Question: Write a caption explaining this figure to a reader.
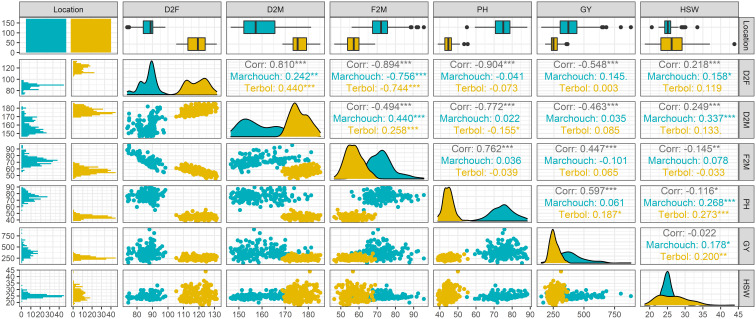
Answer: Pairwise correlations between the agronomic parameters recorded for all chickpea-tested genotypes at Marchouch and Terbol.